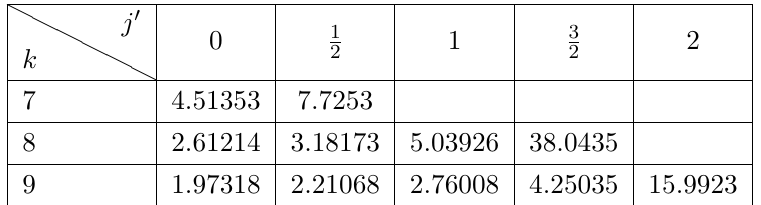
Table 1 . The leading anomalous weight in units of µ 2 for some small values of the level k (or equivalently, the AdS radius) at n = 1 (with h int = 0 ). For each value of k , the range of j 0 considered eventually truncates once the SL(2 , R ) k +2 spin j fixed by the mass-shell condition (4.4) saturates or exceeds the upper bound k (cf (4.6)). 2